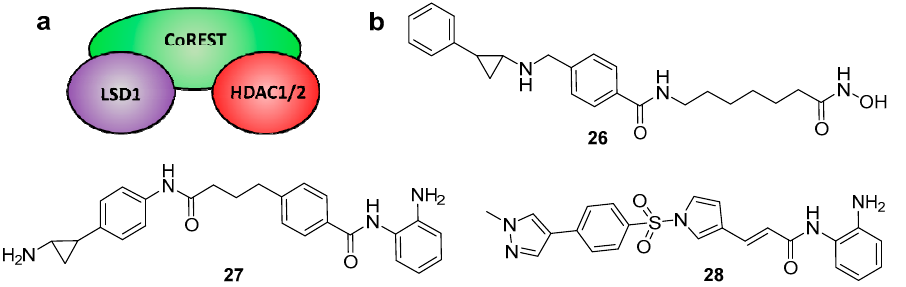
Figure 9. ( a ) Schematic representation of the CoREST corepressor complex. ( b ) Reported examples of dual HDAC - LSD1 inhibitors.